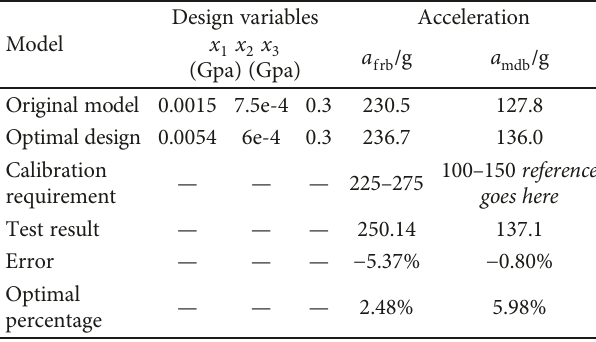
Table 4: Detailed design variables and its corresponding responses compared with the original design and the result obtained by test.